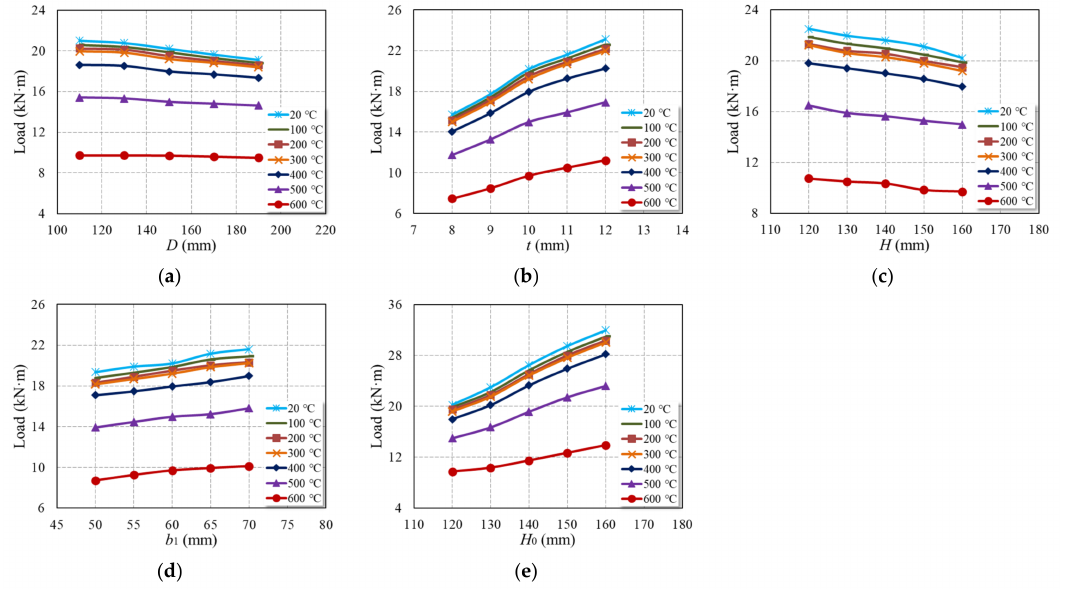
Figure 16. Effects of parameters on the load-carrying capacity of BBC joints under positive bending: ( a ) outer diameter of the tube; ( b ) thickness of the tube; ( c ) height of the tube; ( d ) width of the tubular beam; ( e ) height of the tubular